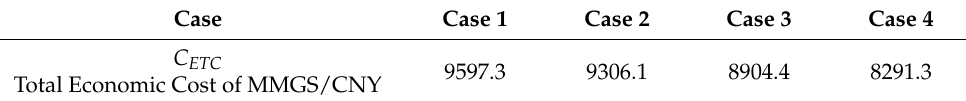
Table 11. The final economic cost of MMGS in the four cases on another